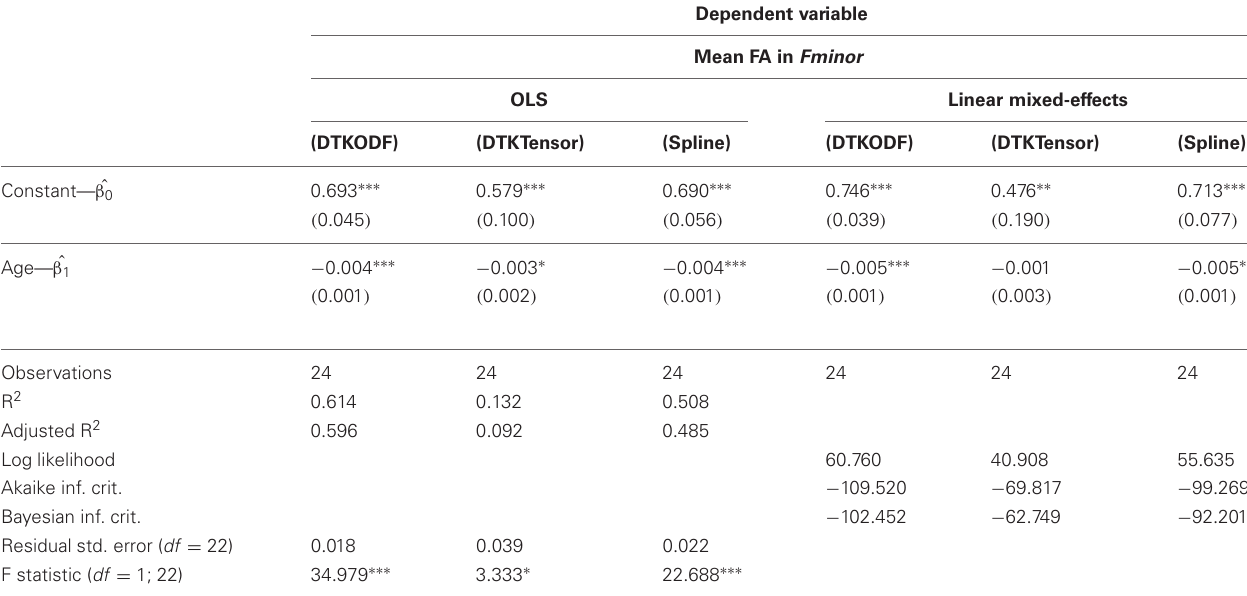
Table 3 | Fminor —Ordinary least squares lm() and linear mixed-model regression lmer() results.